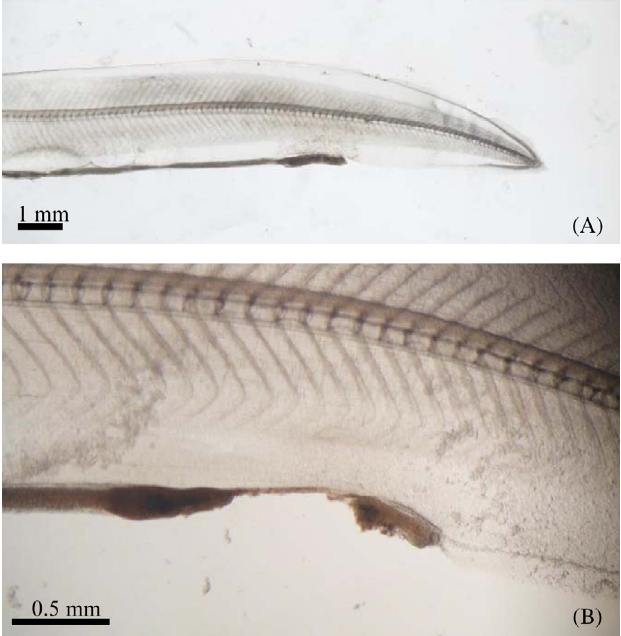
Fig. 4. Melanised gut (A) and necrosis of abdominal region (B) of leptocephali observed in POMEW feeding experiment in